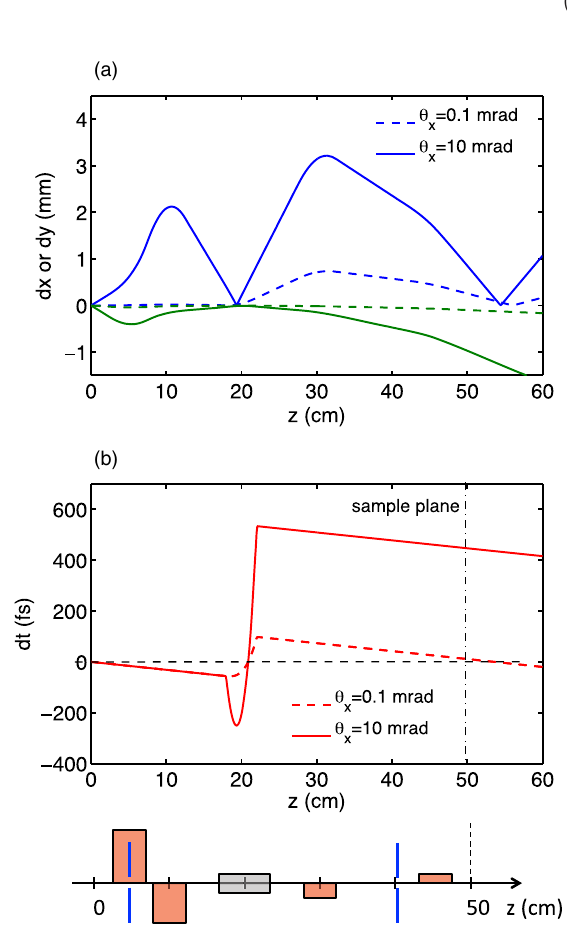
FIG. 4. Ray-tracing model showing electron trajectories through the beam line. (a) Blue lines (green line): Relative displacement dx ( dy ) with respect to the central trajectory. These trajectories originate from the axis dx ¼ dy ¼ 0 and have initial divergences θ x ¼ θ y ¼ 10 mrad (full line) and θ x ¼ θ y ¼ 0 . 1 mrad (dashed line); their momentum is shifted dp=p 0 ¼ 1% . (b) Rel- ative time displacement dt ≃ dl=c for the same trajectories. Bottom: Schematic of the beam